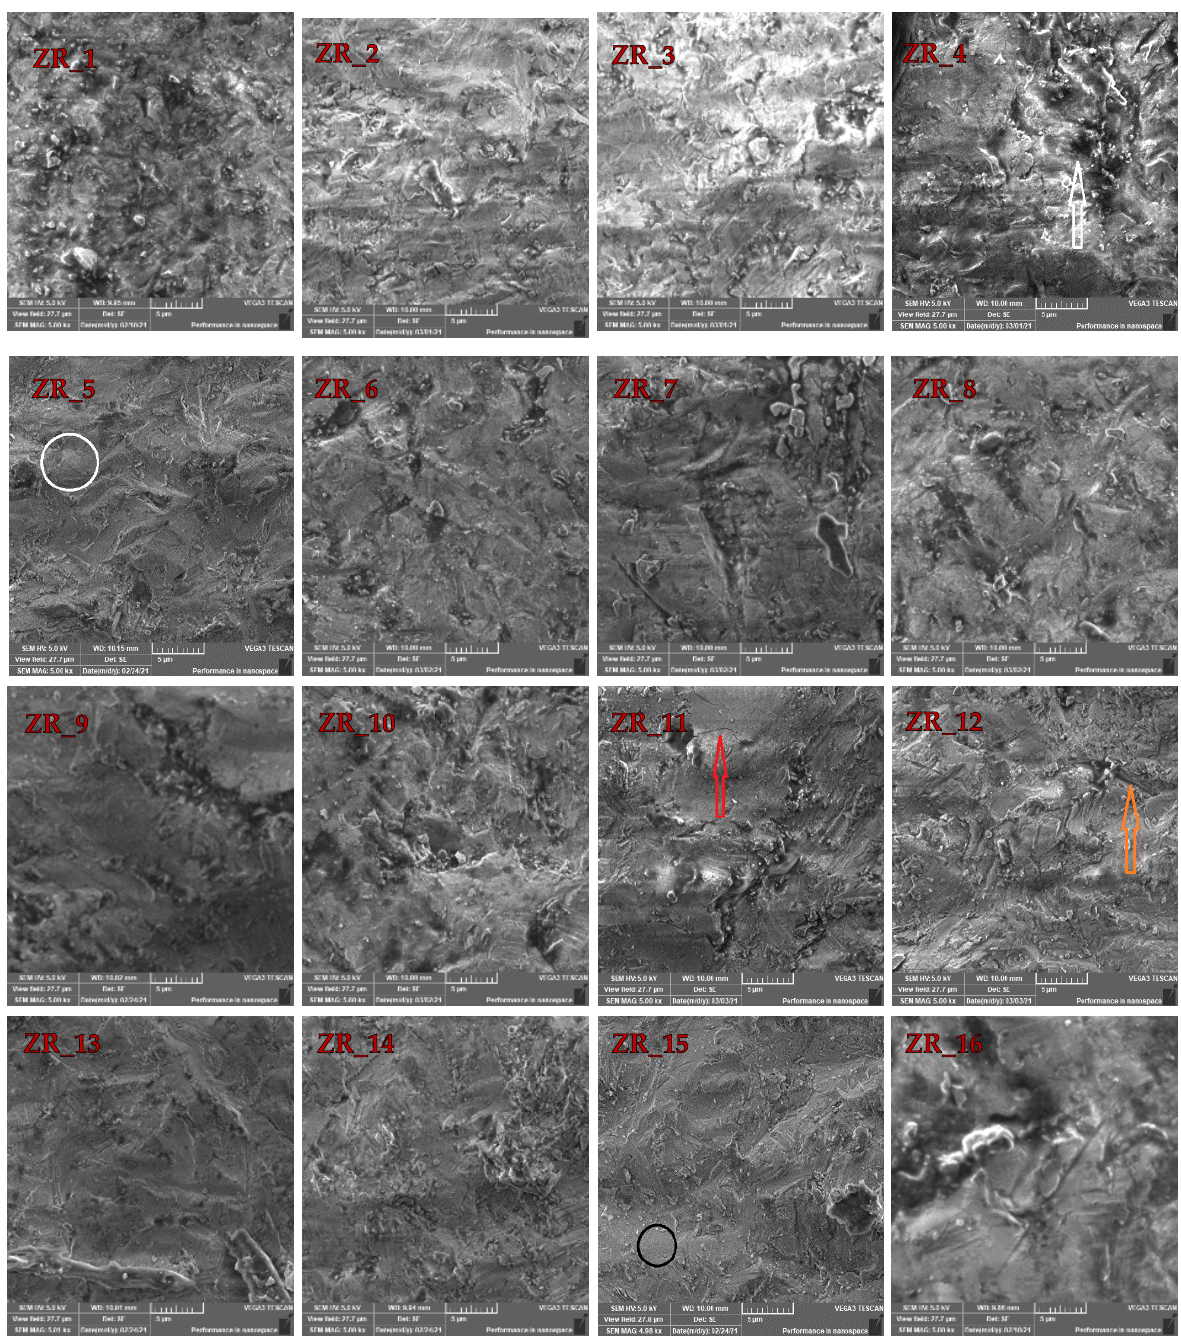
Figure 2. SEM images of the prepared samples (see names in Table 1) obtained after the ZR control sample disk was sandblasted with different Al 2 O 3 particles at diverse pressures. Symbol reference: white arrow indicates holes, red arrow indicates micro-cracks, orange arrow indicates large cracks, black circle indicates surface melting and white circle indicates plastic deformation.